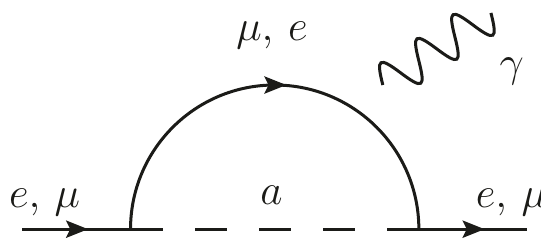
Figure 1 . Feynman diagram for the ALP contributions to the electron and muon g (cid:0) 2. Contri- butions from a(cid:13)(cid:13) and (cid:13)avor-diagonal ALP interactions are assumed to be